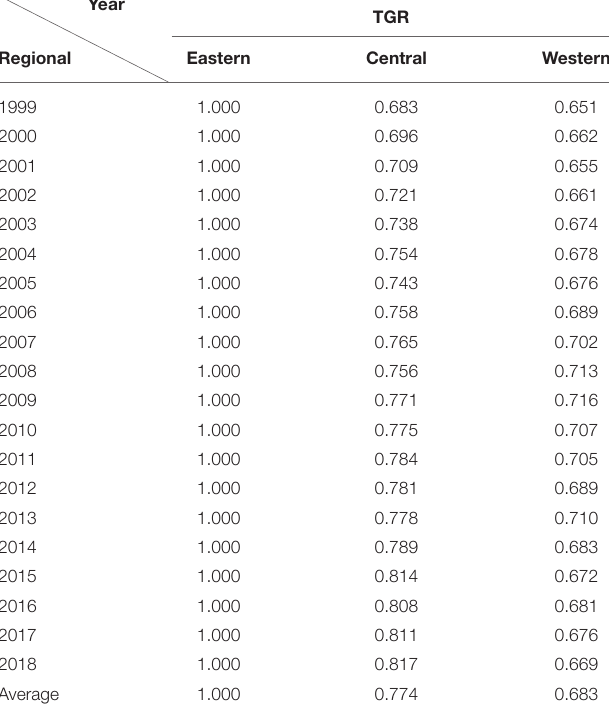
TABLE 4 | Technology gap ratio of health expenditure